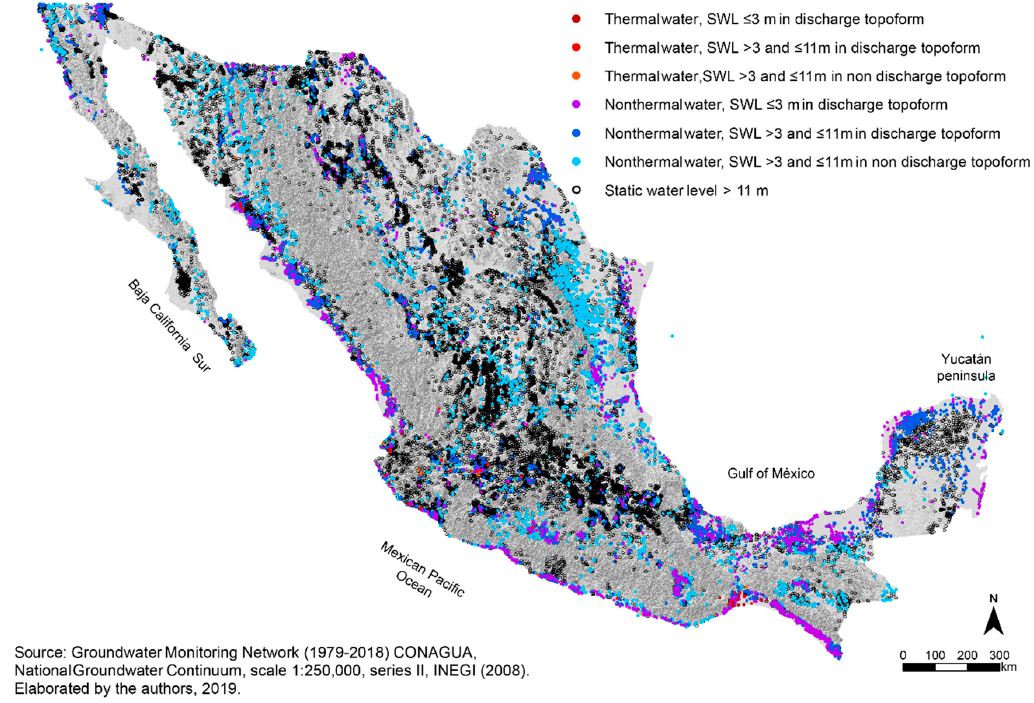
Figure 3. Permanent water on the surface as an indicator of discharge zones of regional groundwater flow systems.